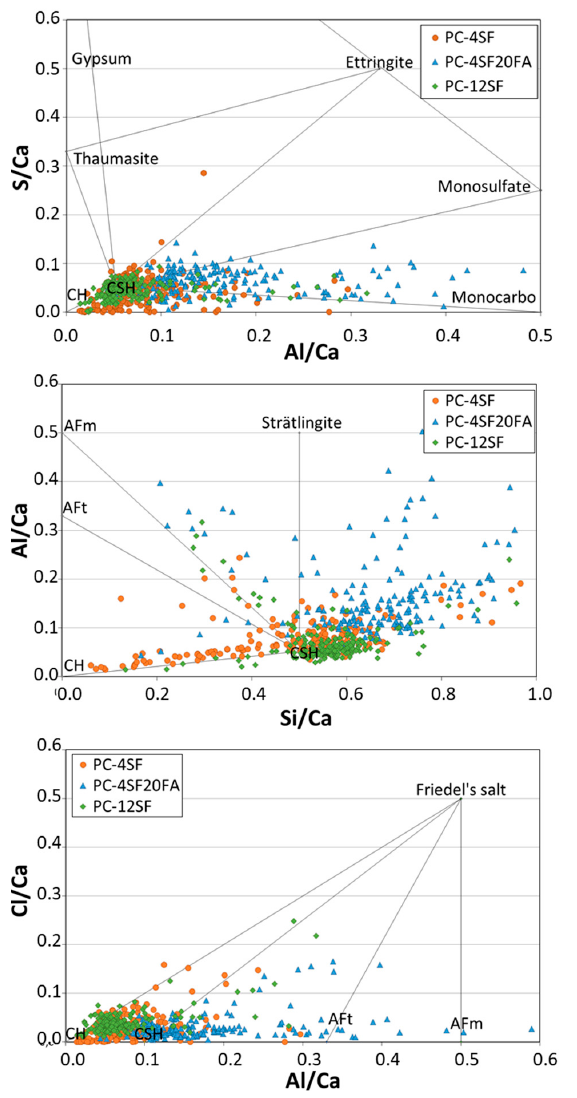
Figure 3. EDX phase analysis of the bulk of the three different binders investigated. Table 6. Predicted hydrate phases of the three different binders based on mass balance calculations [29]. See Section 3.1.1 for assumptions.